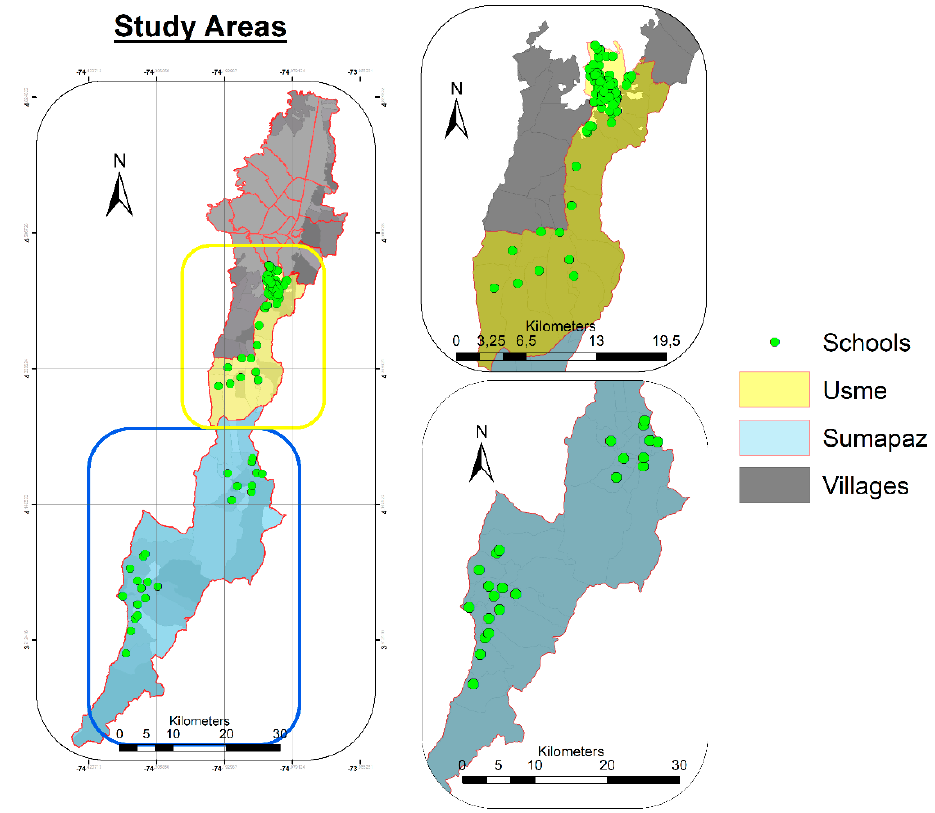
Figure 2. The Map of Sumapaz and Usme.